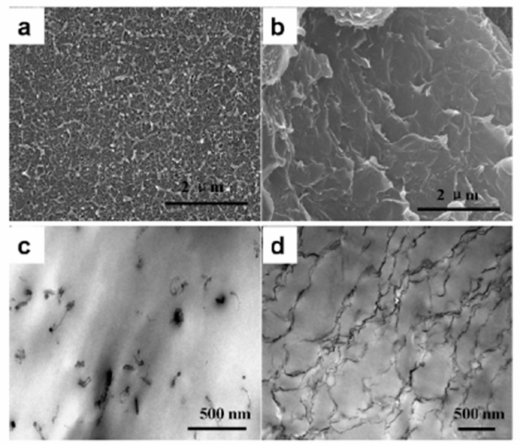
Figure 6. SEM images of PS nanocomposites with ( a ) 1.5 wt.% CNT and ( b ) 1.5 wt.% G. TEM images of PS nanocomposites with ( c ) 1.5 wt.% CNT and ( d ) 1.5 wt.% G [80], reprinted with permission from American Chemical